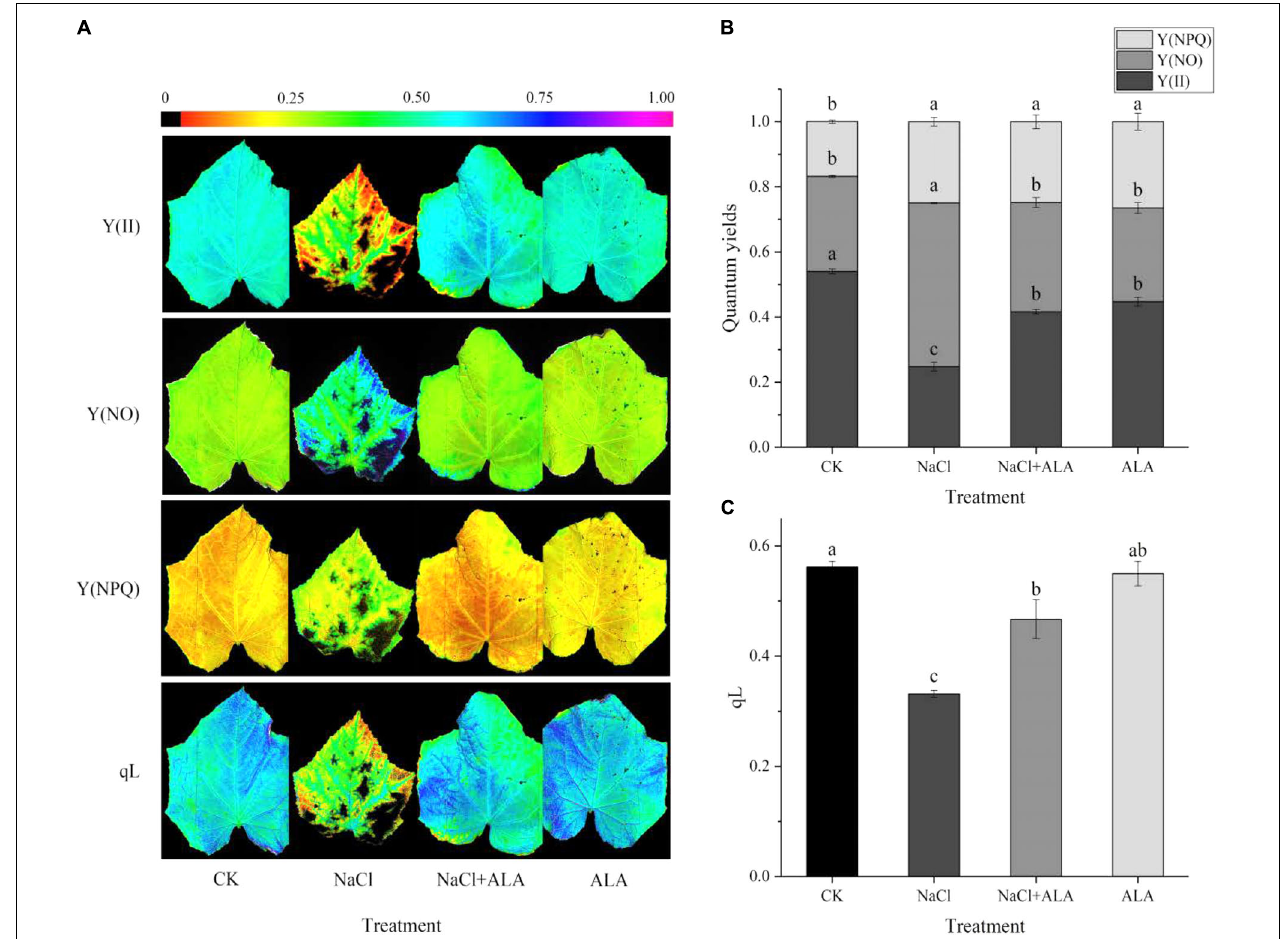
FIGURE 3 | Effects of ALA on chlorophyll fluorescence parameters under salt condition. (A) Chlorophyll fluorescence images, the fluorescence images of the Y(II), Y(NO), and Y(NPQ) are given in corresponding colors that represent the absolute values of the ratio ranged from 0 (black) to 1.0 (purple). (B) Quantum yield of PSII, including Y(II) (actual photosynthetic efficiency of PS II), Y(NO) (the quantum yield of non-regulated energy dissipation) and Y(NPQ) (the effective quantum yield of PS II). (C) Changes of qL (photochemical quenching coefficient). The data presented were the means of three plants ± SE of means ( n = 3). Treatment means with different letters indicate significant differences according to Tukey’s test ( p <